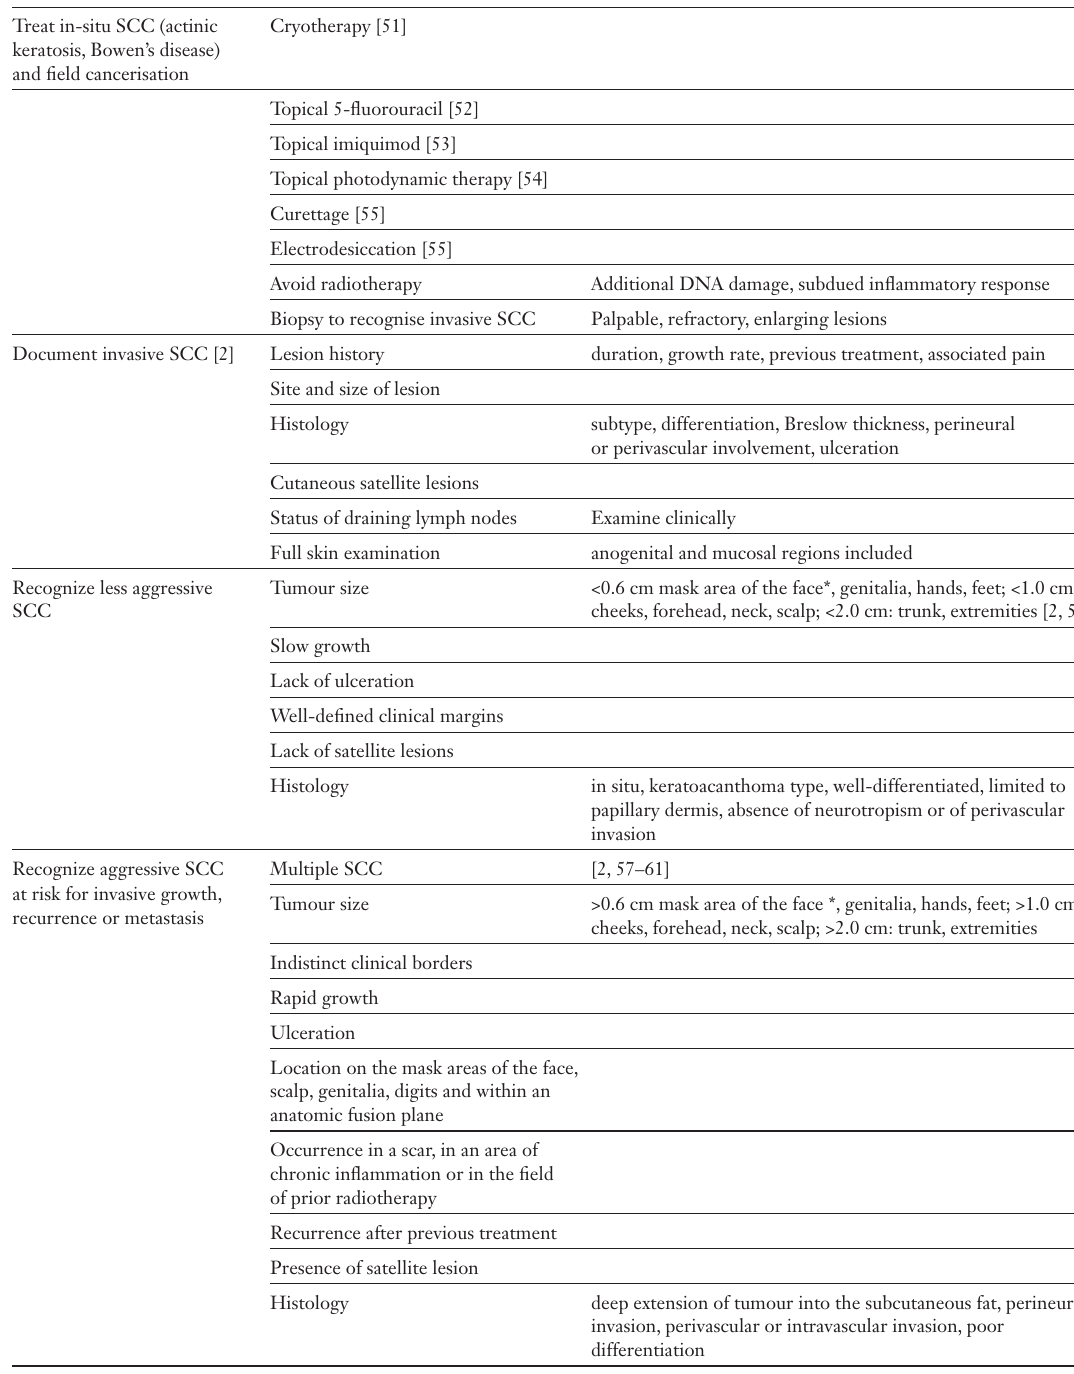
Recommendations for the management of primary SCC in